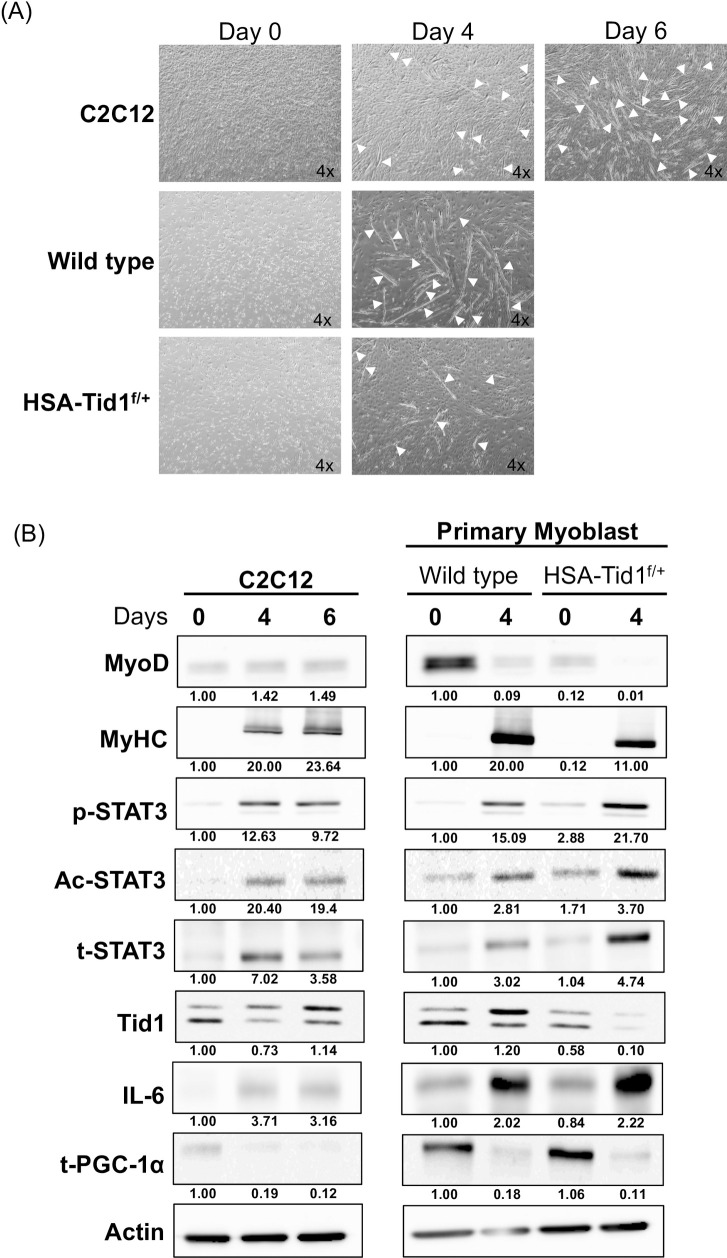
Differentiation of C2C12 and primary myoblast.(A) The representative phase contrast images of C2C12 cells and primary myoblasts under induced differentiation at different time intervals (Day 0, 4 and 6). White arrows indicating the myotube formation. (B) Immunoblot analyses showing the expression profile of myogenesis and mitochondrial biogenesis markers of C2C12 and primary myoblasts under induced differentiation (p-STAT3, phosphorylated STAT3; Ac, acetylated STAT3 and t-STAT3, total STAT3).